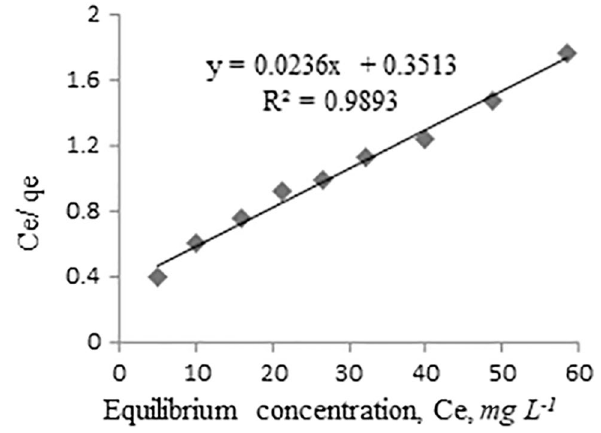
Fig. 3 Langmuir plots for sorption (pH 6, time 30 min, −1 , V = 0.04 L, sorbent dosage 1.25 g L −1 , 20 °C) C 0 = 20–100 mg L